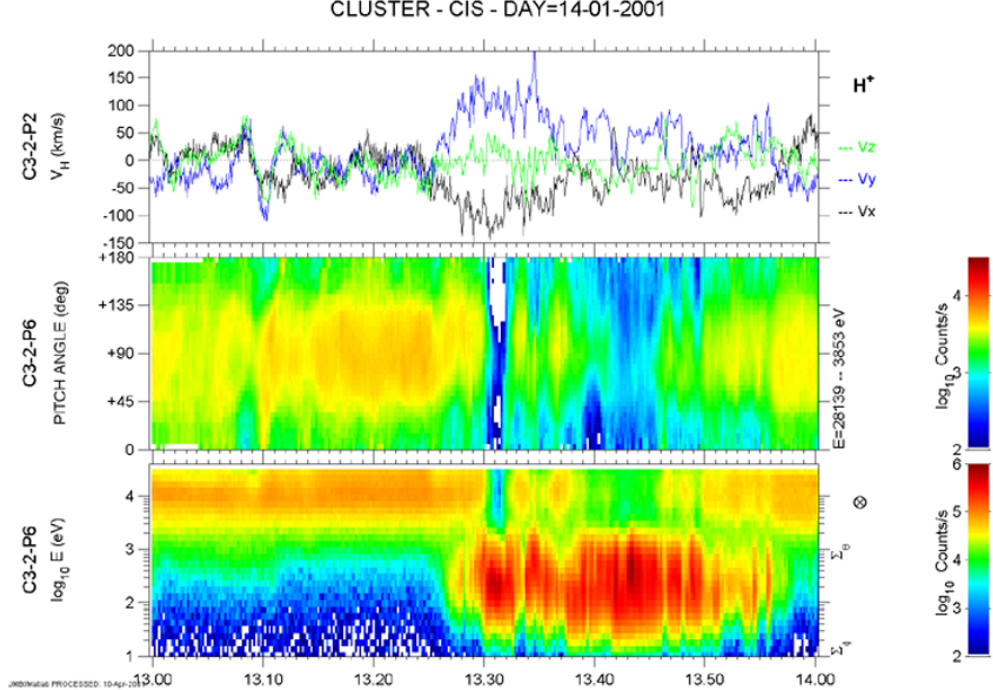
Fig. 15. CIS data on Cluster spacecraft3 from 13:00 to 14:00 UT on 14 Janaury 2001, showing the bulk ion velocity in three components (top panel), the pitch angle distribution of ions in the 3.8–28keV energy range (central panel), and the total ion flux versus energy and time (bottom panel).